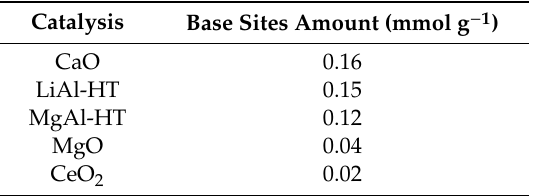
Figure 2. CO 2 -TPD charts of the various solid base catalysts (the specific information of the CO 2 -TPD experiment is shown in the Supplementary Materials). Table 1. The number of base sites over various solid base catalysts.